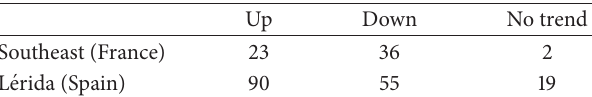
Table 7: Number of stations with positive, negative, and no annual trends, for number of pads impacted from 2001 to 2010 in Southeast France and L´erida